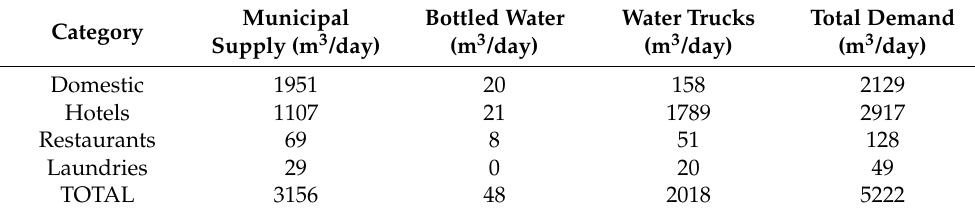
Table 1. Total water demand quantification for Puerto Ayora for different categories